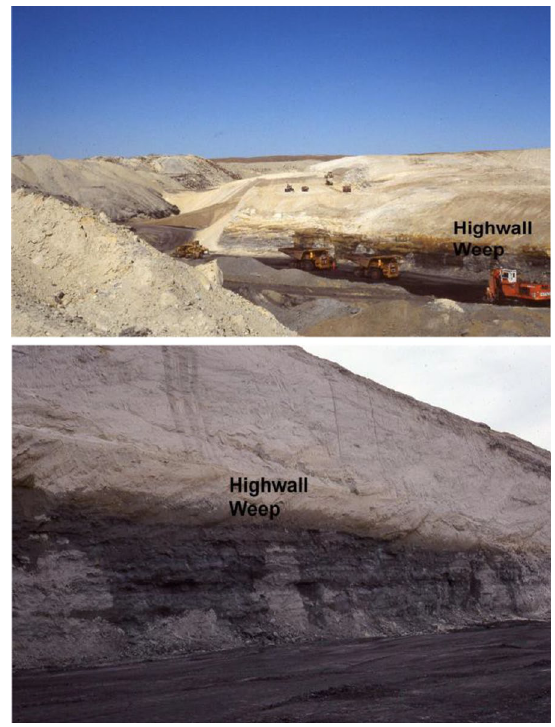
Fig. 13 Development of highwall weeps or “seeps”